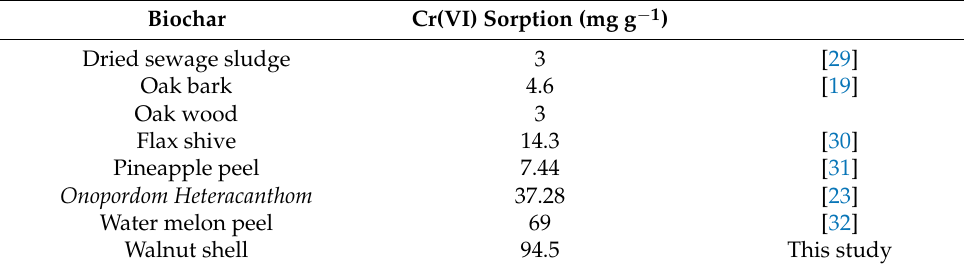
Figure 7. XPS survey scan of chromium adsorption on the walnut shell biochar. Table 3. Adsorption capacity of WSB and comparison with other